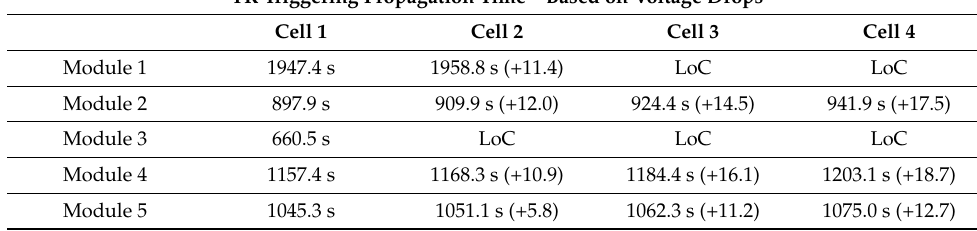
Table 2. TR propagation times based on the voltage drop measurements. Some values are miss-